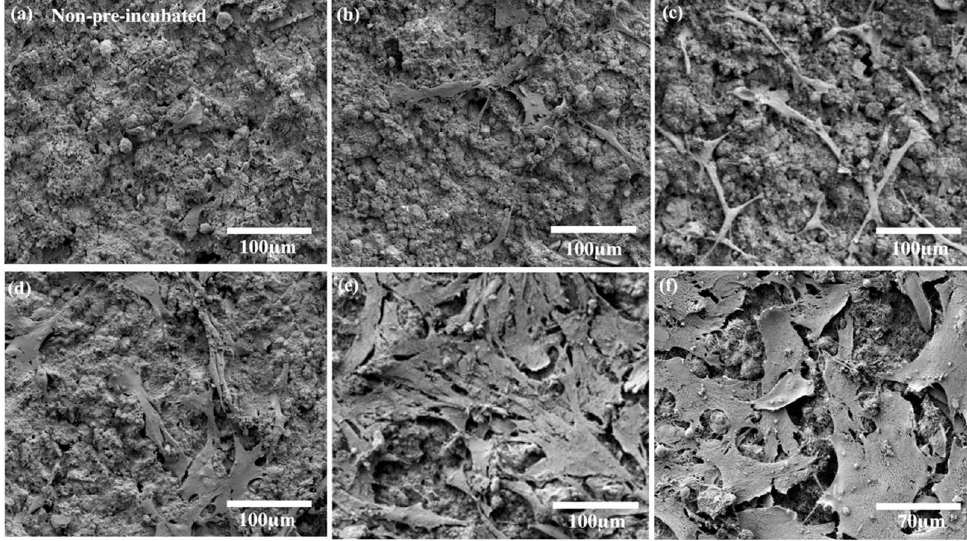
Figure 5. SEM micrographs of the hMSC morphology cultured on FHA-Mg-based scaffolds ( a ) without pre-incubation, and after ( b ) 3, ( c ) 5, ( d ) 7, and ( e , f ) 14 days of incubation. Image f is an SEM micrograph with higher